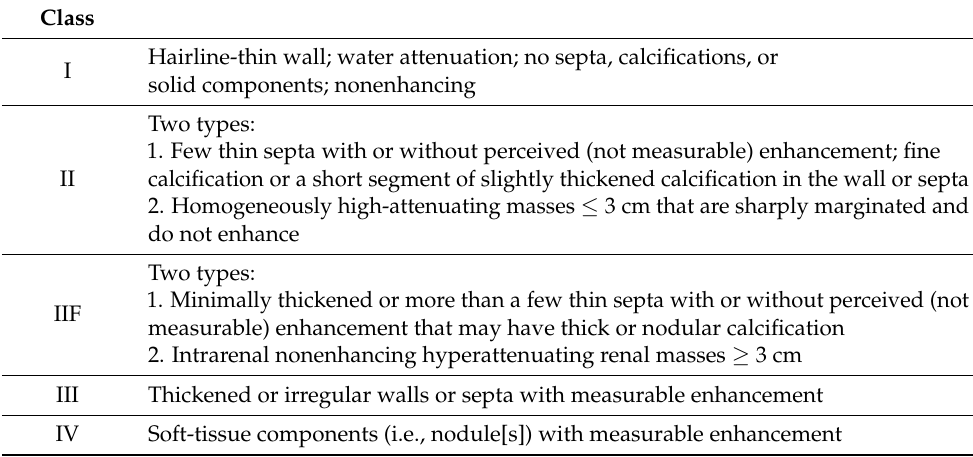
Table 2. Bosniak Classification [17].